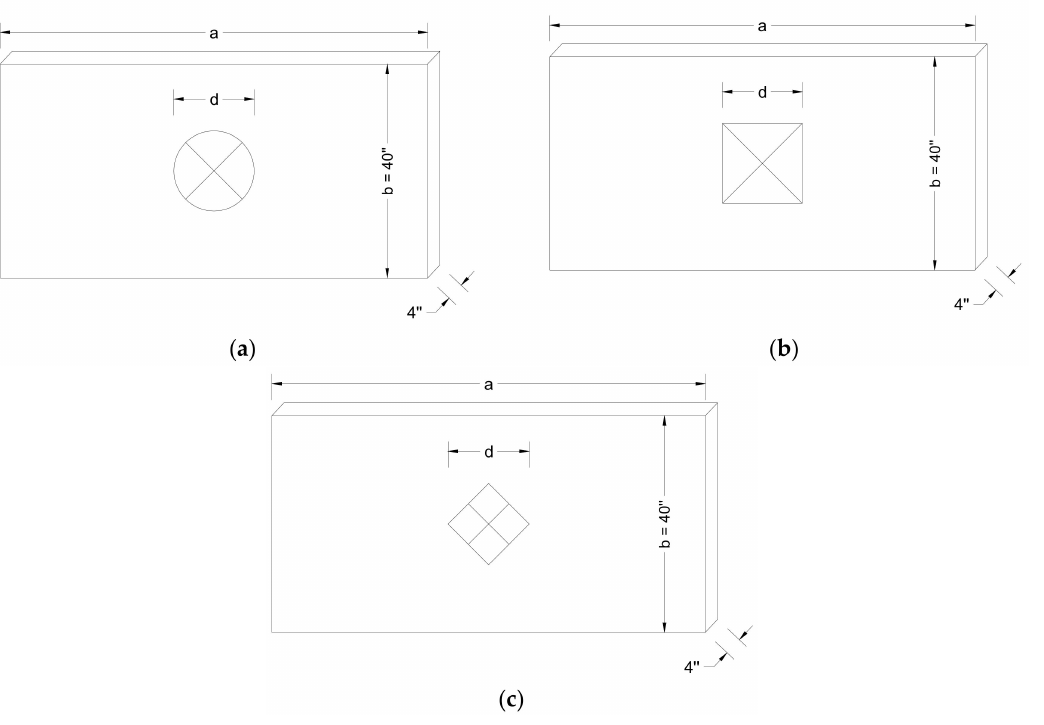
Figure 4. Schematic of the FGM plates with ( a ) circle opening, ( b ) square opening, and ( c ) dia- mond